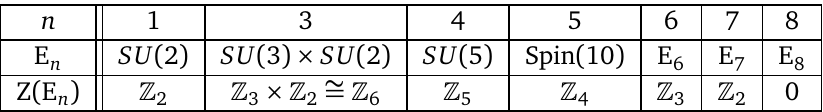
Table 5: Simply-connected E